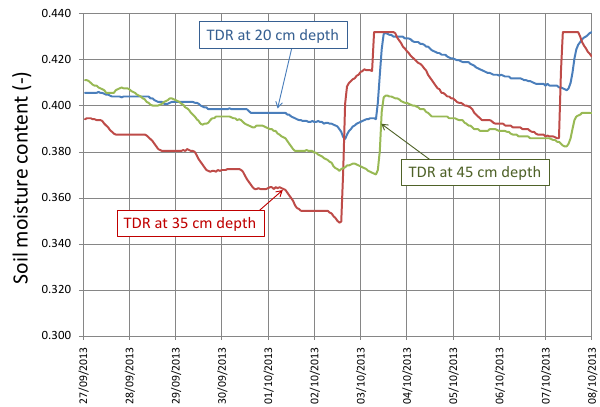
Figure 8. Moisture content time series from three TDR probes lo- cated about 1.5m from the ERT-monitored tree. The signal coming from the irrigation experiment of 2 October 2013 is very clear. Be- fore this experiment the system had been left without irrigation for about a